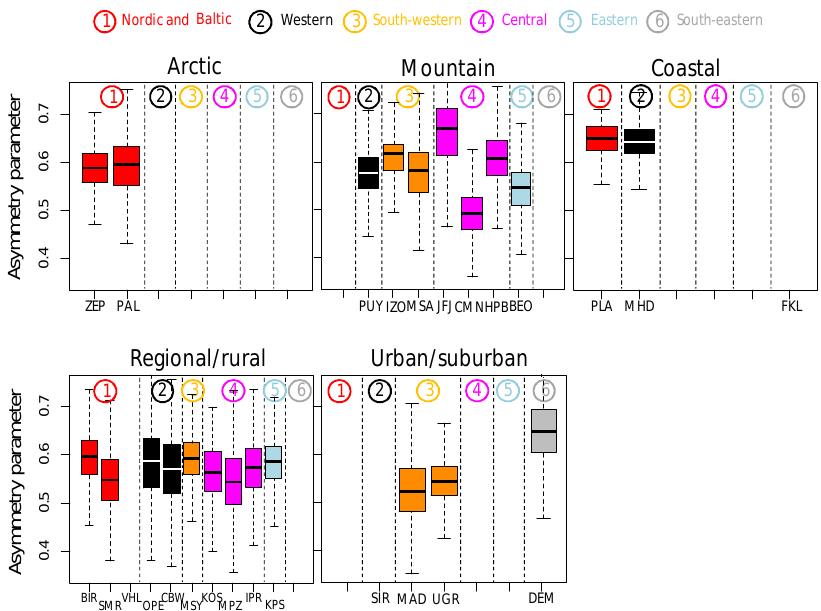
Figure 5. Asymmetry parameter in the green divided by station setting. Different colours highlight different geographical locations. Medians (horizontal lines in the boxes), percentiles 25 and 75 (lower and upper limits of the boxes) and percentiles 5 and 95 (lower and upper limits of the vertical dashed lines) are reported. Hourly data were used for the